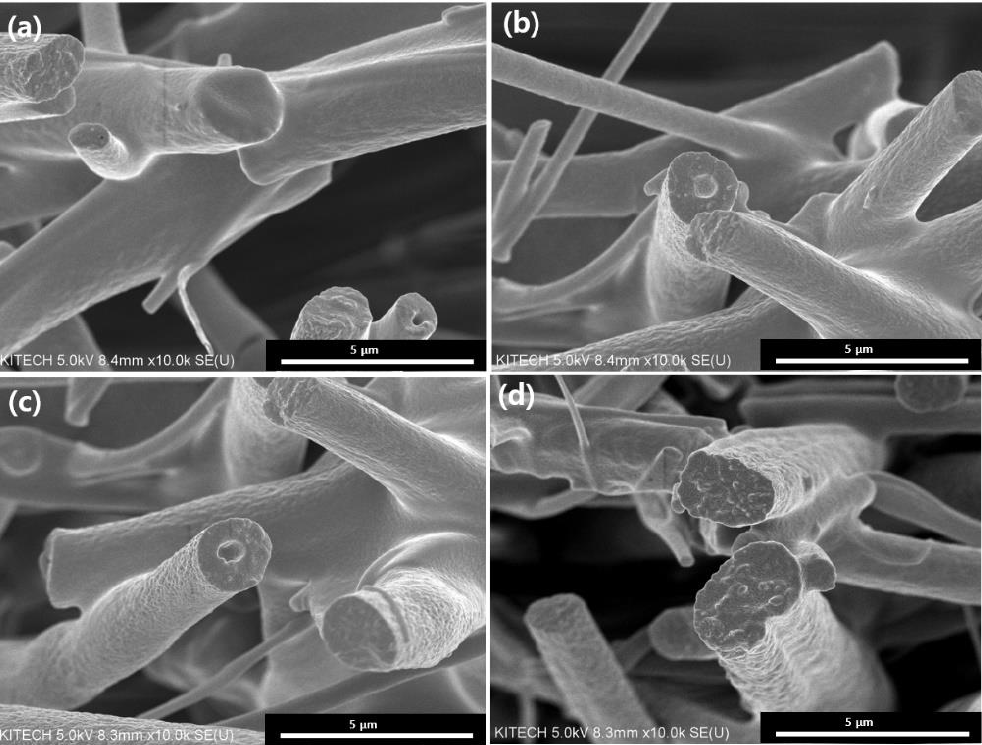
Figure 2. SEM images of hollow and solid TiO 2 fibers before calcination: ( a ) TiO 2 @C1, ( b ) TiO 2 @C2, ( c ) TiO 2 @C3, and ( d ) TiO 2 @C0.